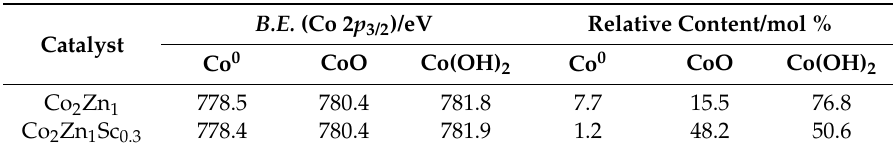
Figure 6. X-ray photoelectron spectroscopy (XPS) profiles for the spent catalysts of (a) Co 2 Zn 1 Sc 0.3 and (b) Co 2 Zn 1 ; ( A ) Co 2p; ( B ) Zn 2p; ( C ) Sc 2p; ( D ) O 1s. Table 2. XPS binding energy and relative content of the Co species with different valence states at the surface of the tested catalysts.